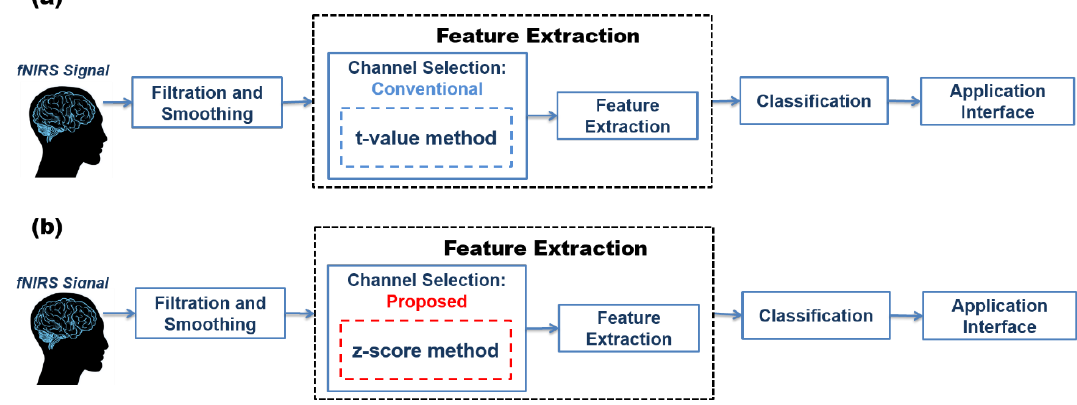
Figure 4. Methodology of (a) conventional and (b) proposed brain–computer interface (BCI) system.